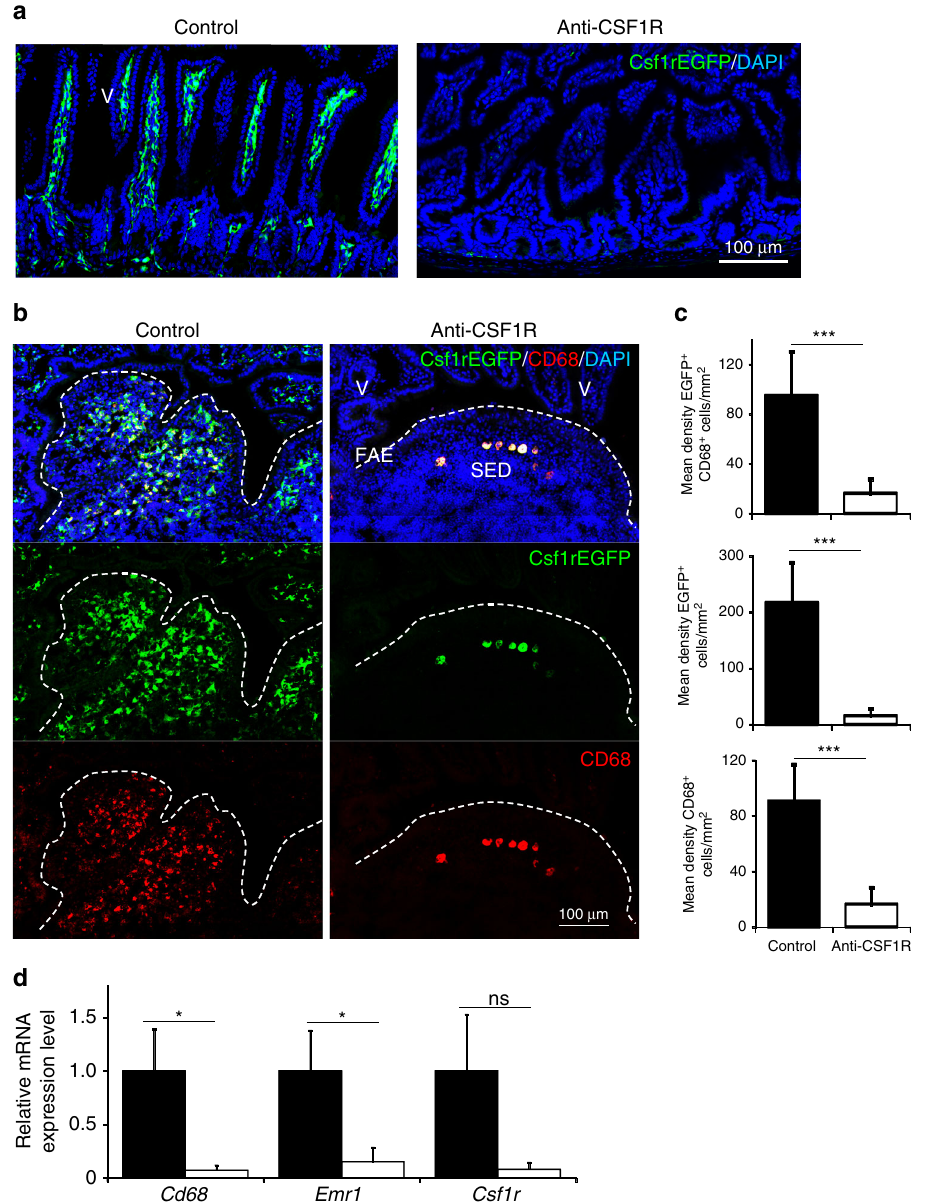
Fig. 1 Prolonged anti-CSF1R blockade depletes macrophages in the gut. Csf1r -EGFP mice were treated with anti-CSF1R mAb or control-IgG (control) for 6 weeks before analysis. a Depletion of Csf1r -EGFP + (green) macrophages in the gut wall of anti-CSF1R mAb-treated mice. Scale bar, 100 µ m. Images are representative of four mice/group from three independent experiments. b Detection of Csf1r -EGFP + (green) and CD68 + (red) macrophages in Peyer ’ s patches by IHC. FAE, follicle-associated epithelium; SED, subepithelial dome; V, villus. Broken lines indicate the FAE boundary. Scale bar, 100 µ m. c Morphometric analysis of the density of Csf1r -EGFP + CD68 + macrophages in Peyer ’ s patches. Data represent mean ± SD from 2 to 10 sections from 3 to 4 mice/group. *** P < 0.001, two-tailed unpaired Student ’ s t -test. d RT – qPCR analysis of Cd68 , Emr1 , and Csf1r expression in Peyer ’ s patches. Bars represent mean ± SEM. Data are derived from 3 to 4 mice/group. * P < 0.05, two-tailed unpaired Student ’ s t -test. NS not signi fi